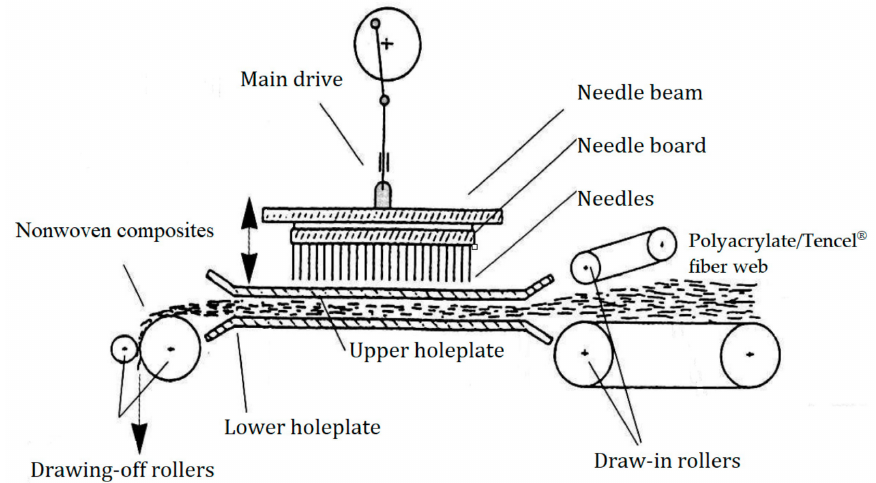
Figure 1. Schematic illustration of the PT nonwoven composites’ manufacturing process.